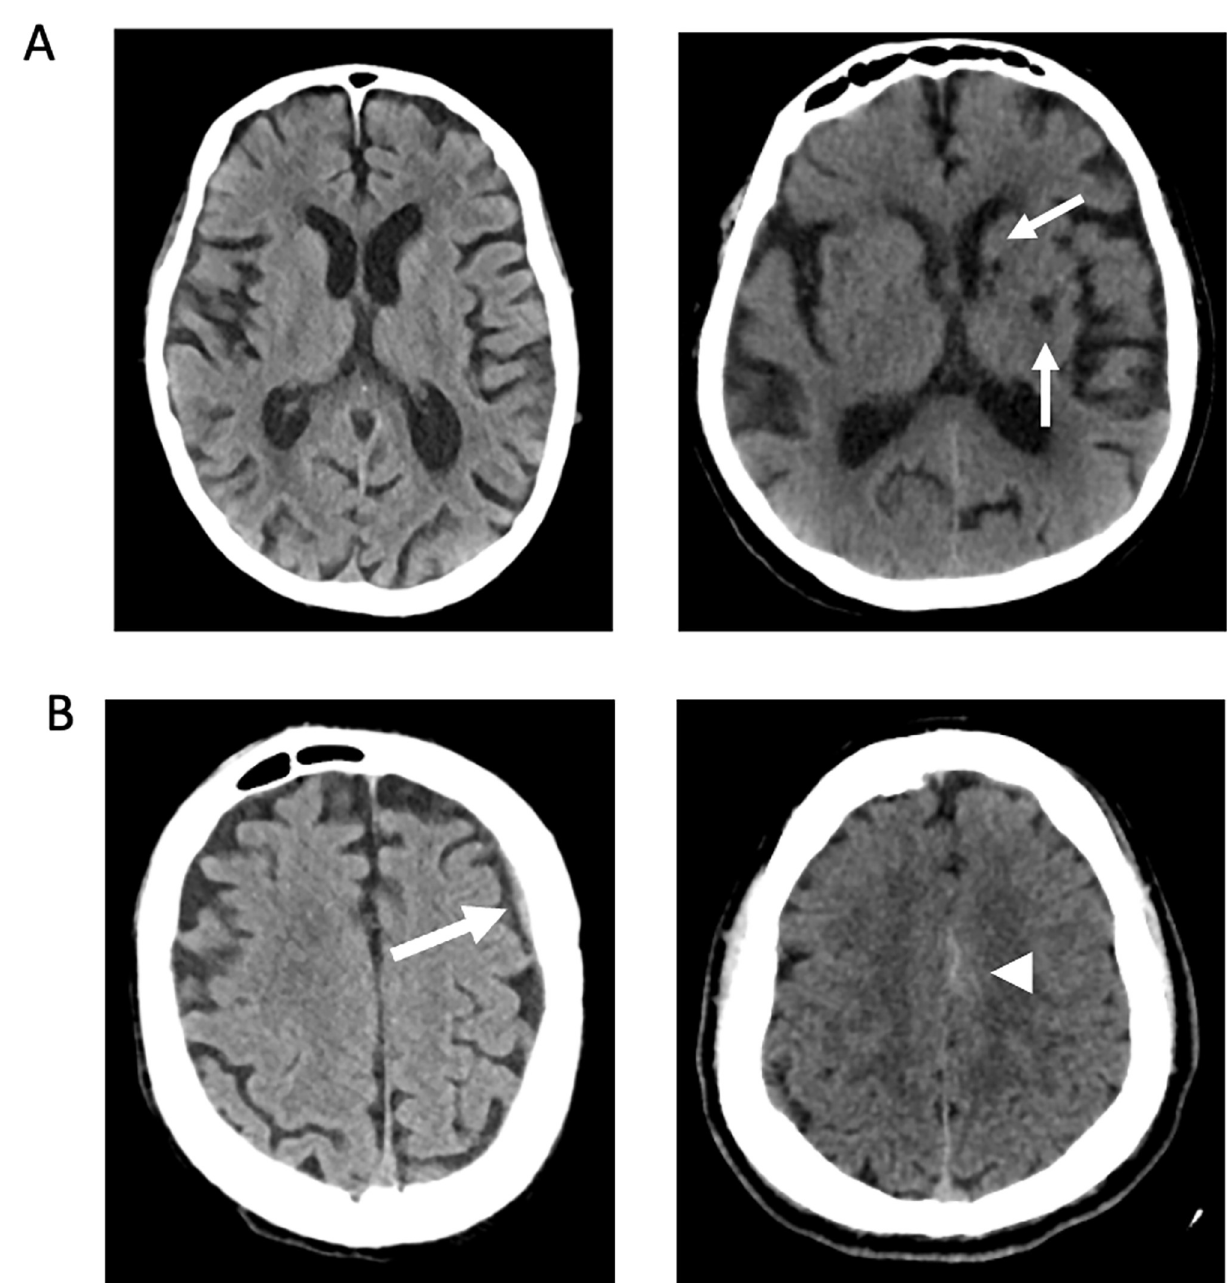
Fig 2. IC- cases. A: Examples of true negative IC- cases. The left panel shows a normal noncontrast head CT. The right panel shows small old infarcts in the left basal ganglia. B: Examples of false negative IC- cases. The left panel shows a small isodense subdural hematoma along the left frontal convexity. The right panel shows trace subarachnoid hemorrhage along the medial aspect of the left frontal lobe. 24.4%, 17.7–32.7). Compared to the IC+ and IC- groups, the NP group demonstrated the high- est proportion of scans with artifacts (n = 19, 11.3%, 7.3–17.1) as well as postoperative changes that include the presence of a resection cavity or pneumocephalus from craniotomy without acute intracranial hemorrhage or substantial mass effect (n = 33, 19.6%, 14.1–26.6). Other scans include those with non-hemorrhagic mass/mass effect with urgent findings (n = 7, 4.2%,